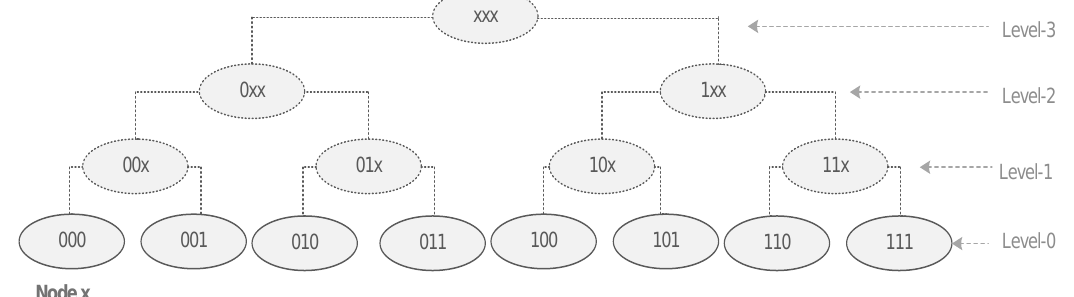
Figure 2. The Address